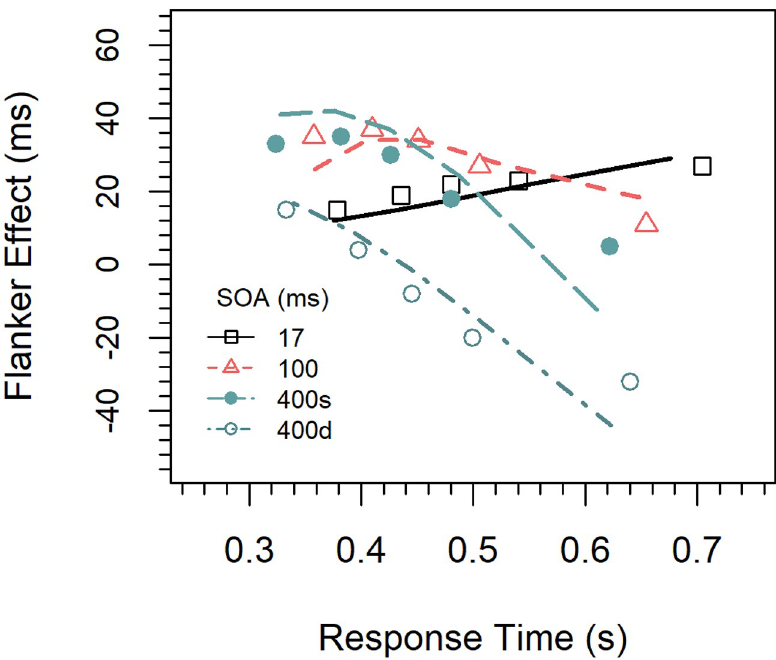
Fig 9. Delta functions for the different conditions in Experiment 2 (data points). The lines represent the fit of the DSTP model.